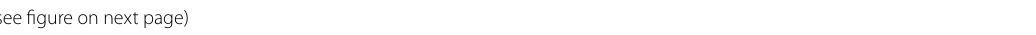
Fig. 3 Forest plot indicating weighted mean difference (95% CI) in the reduction of assessed treatment outcomes following non-surgical treatment of peri-implantitis. a Alternative measures for biofilm removal (patient-level analysis)—BOP. b Alternative measures for biofilm removal